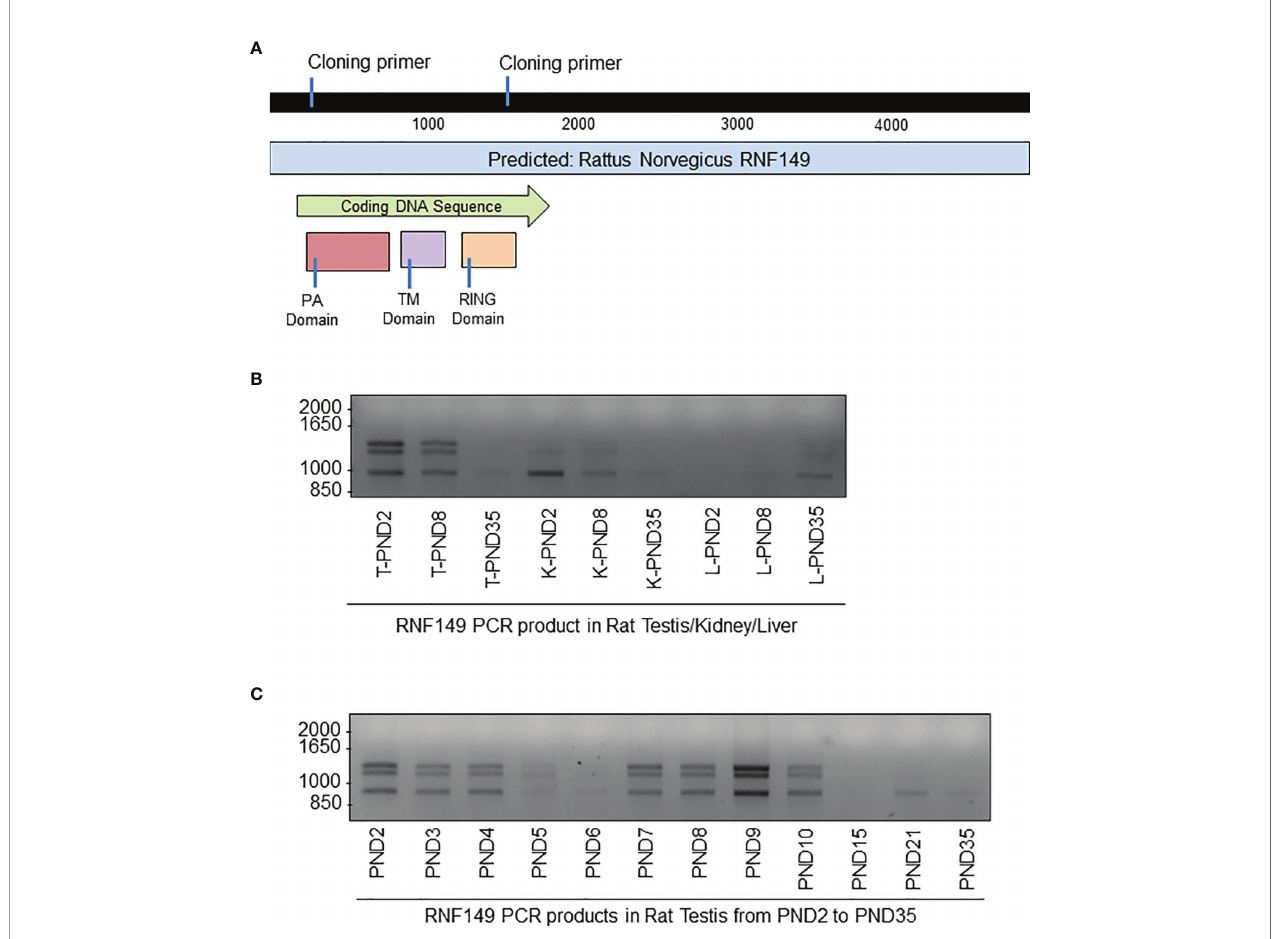
FIGURE 5 | PCR analysis of RNF149 sequences cloned from tissues of rat pups at different ages. (A) Gene map of RNF149. Blue bar represents total predicted gene, green bar represents the RNF149 coding sequence that includes the PA domain (red), transmembrane TM domain (purple), and RING domain (orange). (B) PCR products of RNF149 in rat testes at various ages. (C) PCR products of RNF149 in various rat organs and various ages. T, testis; K, kidney;